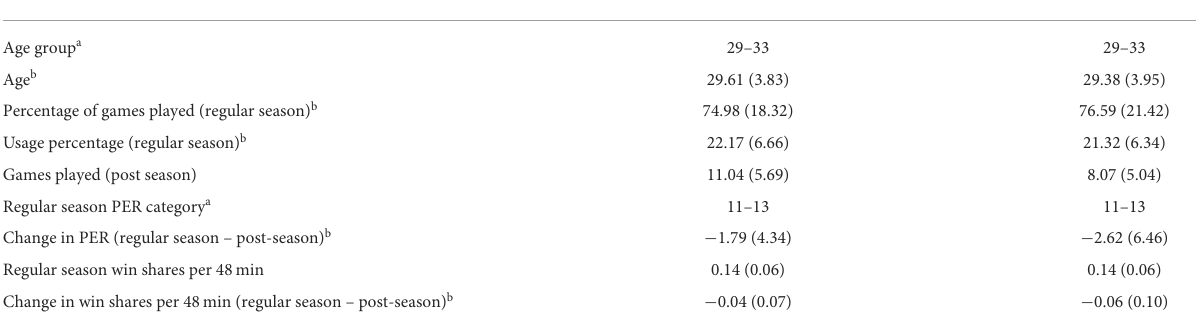
TABLE 2 Descriptive statistics for matched cases and